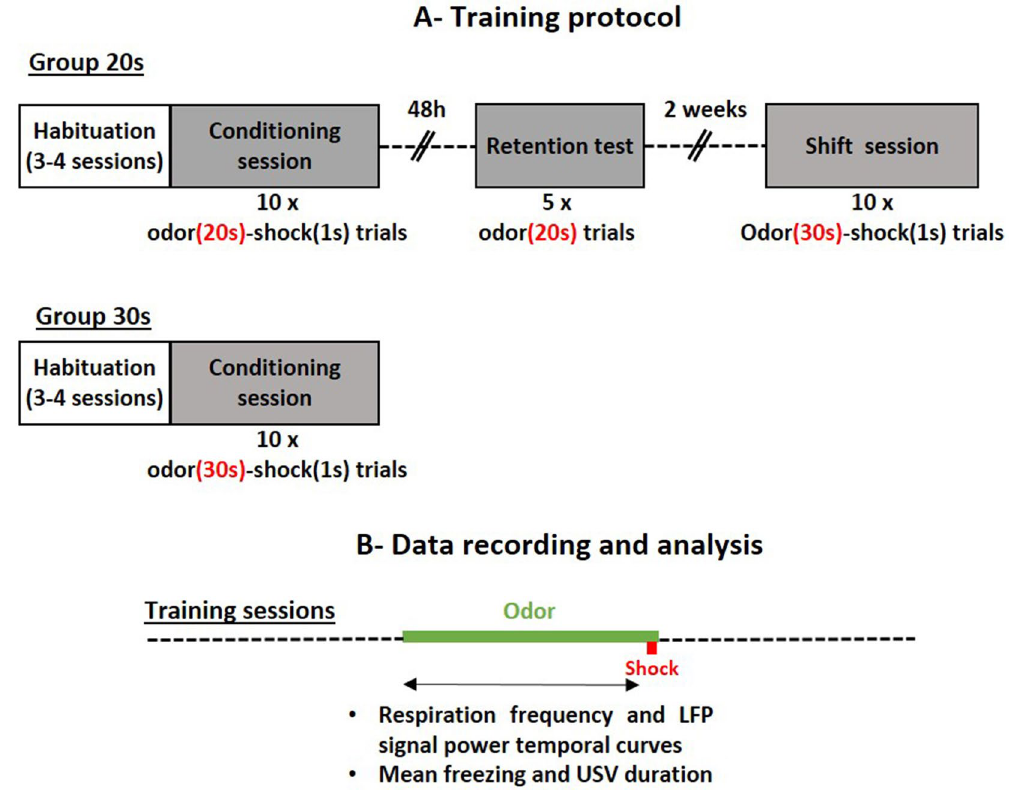
Figure 1. ( A ) Training protocol. Group 20 s: the animals were trained with 10 Odor-Shock pairings using a 20 s Odor-Shock interval (Conditioning session). 48 h later, they were tested for their retention of the learning (Retention test) with 5 presentations of the learned odor. Two weeks later they were trained with 10 Odor- Shock pairings using a 30 s Odor-Shock interval (Shift session). Group 30 s: The animals were trained with 10 Odor-Shock pairings using a 30 s Odor-Shock interval (Conditioning session). ( B ) Data recording and analysis. Training sessions: in the two groups, during the odor-shock interval, local field potentials (LFP), respiration, ultrasonic vocalizations and freezing behavior were recorded, synchronized and analyzed as described in the